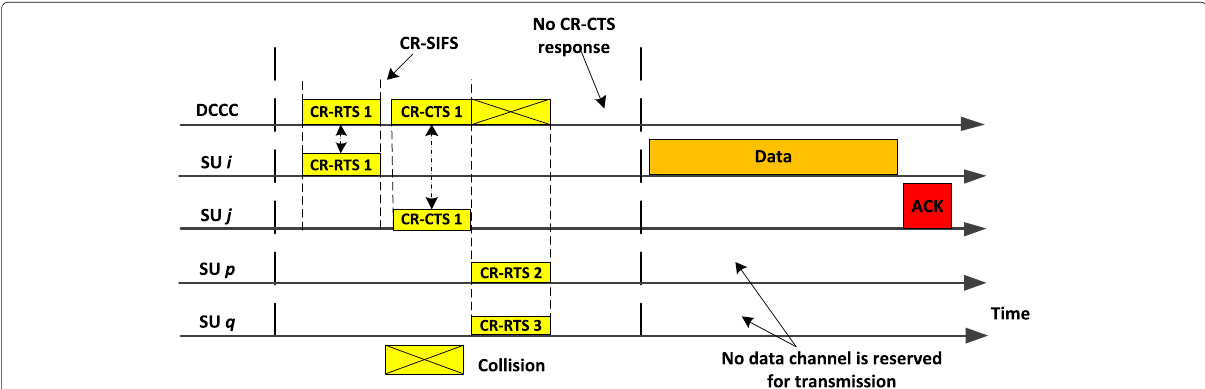
Fig. 1 Slotted ALOHA contention scheme. An example about the slotted ALOHA contention scheme, which is used in the proposed MAC